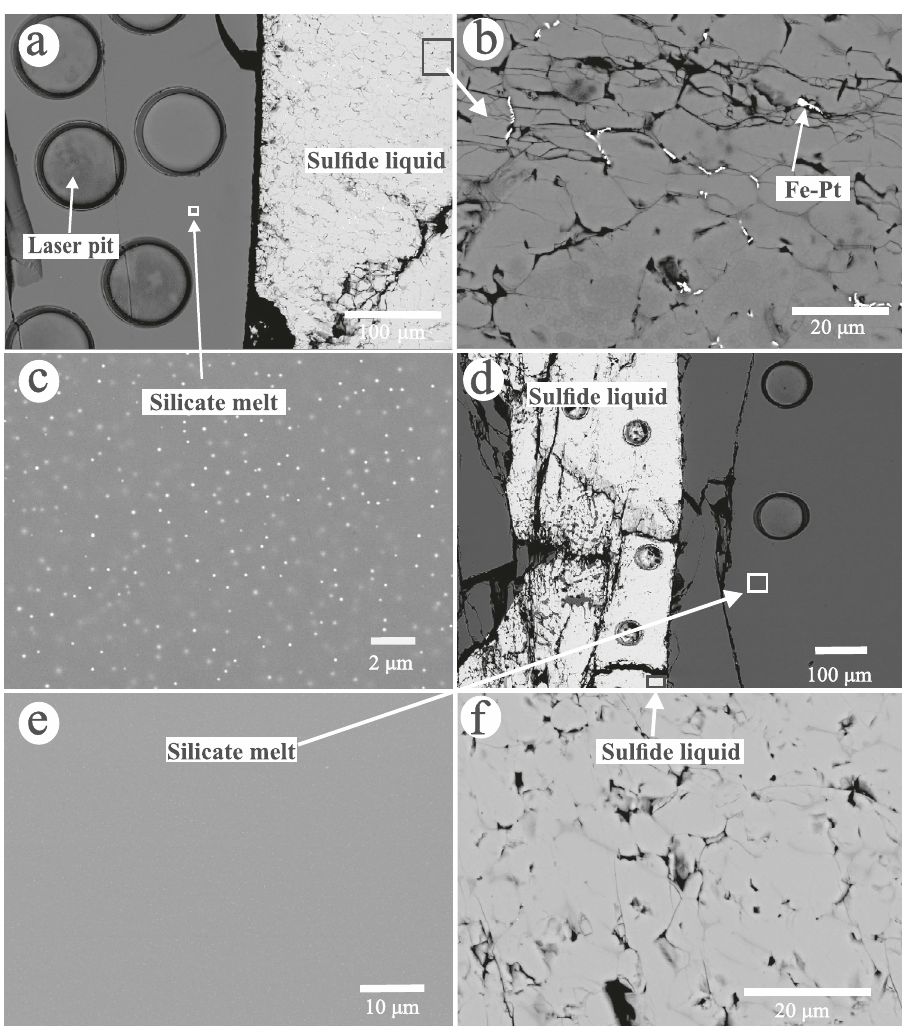
Fig. 1 Selected back-scattered electron images showing characteristic features of the run products of sul fi de liquid – basaltic melt partitioning experiments. a BSE image of run Z14, showing coexisting sul fi de liquid and silicate melt in a graphite capsule. b Closer view of the quenched sul fi de liquid with 5300 ppm Pt from run Z14, which includes large pyrrhotite crystals and exsolved Fe-Pt alloys at the boundary of pyrrhotite crystals. c Closer view of the quenched silicate melt in ( a ), showing homogeneously distributed small sul fi de dots (< 0.1 µ m) produced during quench. d BSE image of one reversal experiment (run Z28) for Pd partitioning, showing coexisting sul fi de liquid and silicate melt. e Closer view of the quenched silicate melt in ( d ). f Closer view of the quenched sul fi de liquid with 163 ppm Pd in ( d